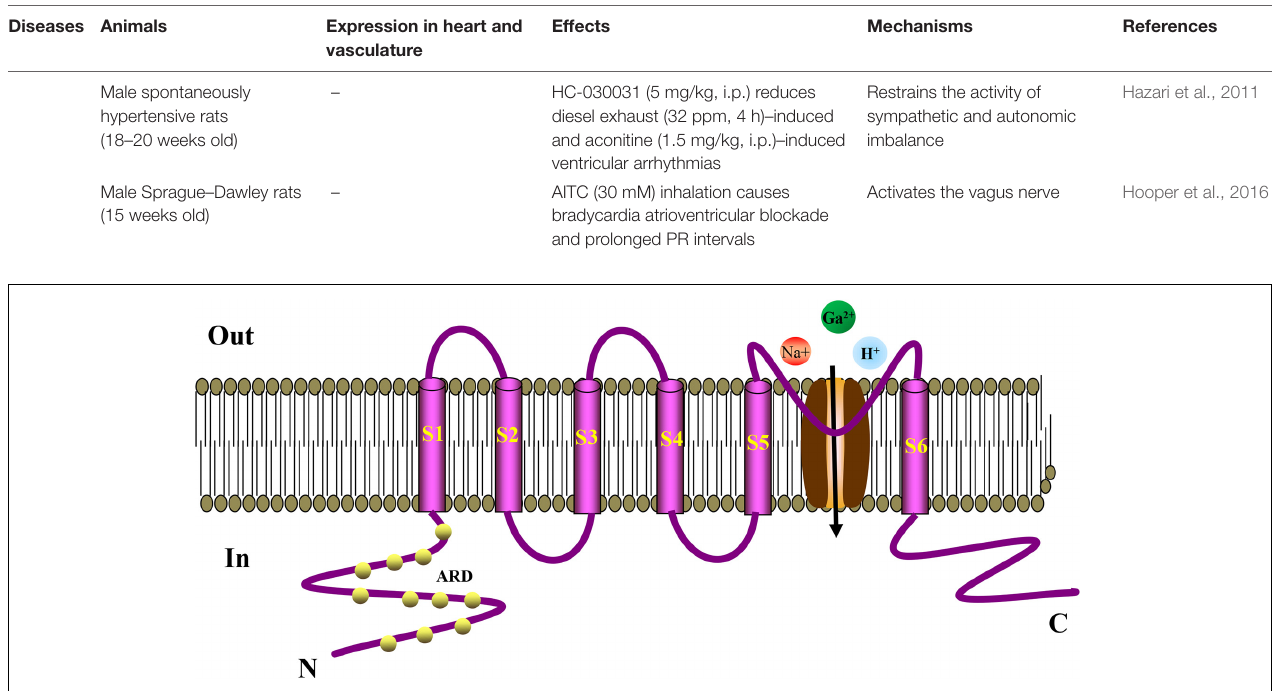
FIGURE 1 | Schematic diagram showing the structure of TRPA1 channel. The TRPA1 channel has a six-time transmembrane structure (S1–S6), and there is a minute opening between S5 and S6 for ions to enter and exit the cell membrane. The N-terminus and C-terminus of the channel protein are located inside the cell. The N-terminus has a large number of characteristic ankyrin repeats, and the cysteine residues in these repeats serve as binding targets for the covalent modification of TRPA1 agonists. TRPA1 can increase the influx of extracellular cations, such as Na + , H + , especially Ca 2 + , thereby mediating a series of physiological reactions. ARD, Ankyrin Repeat